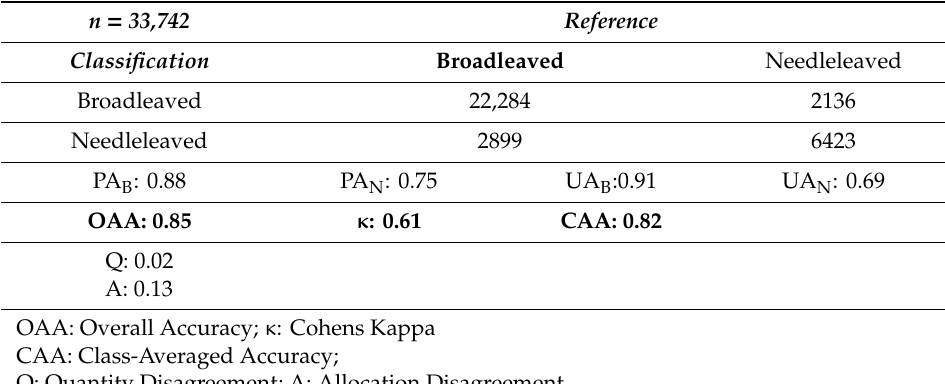
Table 3. Confusion matrix and derived accuracies for RGB + nIR + Texture classification under the manual training setup.